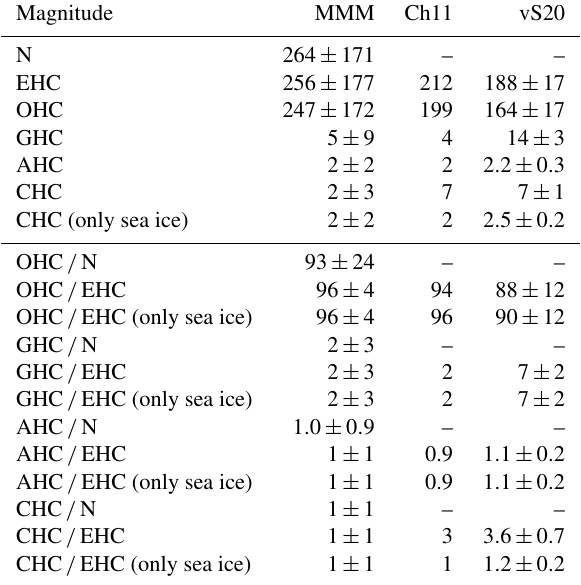
Table 2. Earth heat inventory and proportion of heat allocated in each climate subsystem from the 30 CMIP5 GCMs analysed here (MMM), and observations from Church et al. (2011) (Ch11) and von Schuckmann et al. (2020) (vS20). Heat storage in ZJ, heat proportion in %. Magnitude MMM